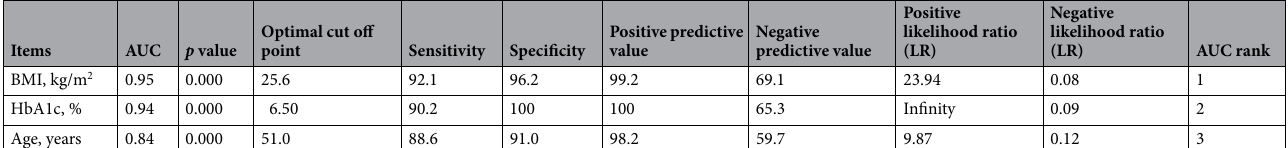
Table 3. ROC analysis to estimate the optimal cut-off point for the blood biochemical markers, age, and BMI to determine diabetes incidence. The analysis was carried out by determining the predictive power and cut-off point of the objects with the highest AUC (i.e., ≥ 80) for the detection of diabetes incidence. The optimal cut-off was calculated by maximizing the Youden index. BMI body mass